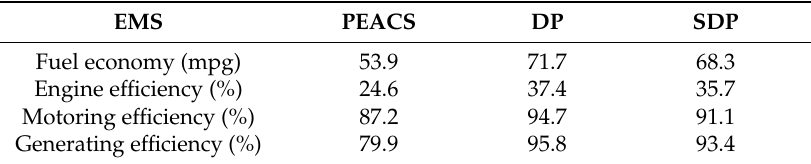
Table 3. Simulation results for CYC_UDDS.